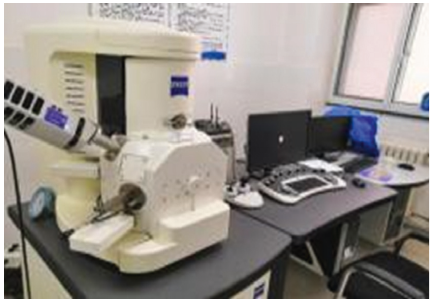
Figure 15: Sample after gold plating. Figure 16: Scanning electron